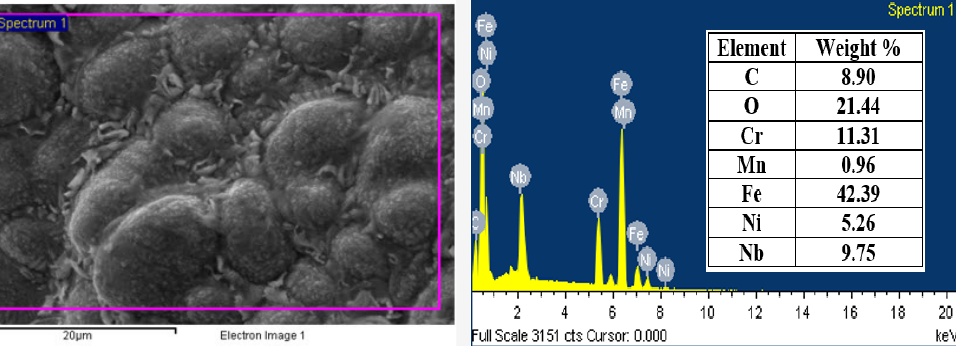
Figure 11. EDS spectral analysis in the lateral solidification hot cracking face in TIG weld coated by pure Nb powder.